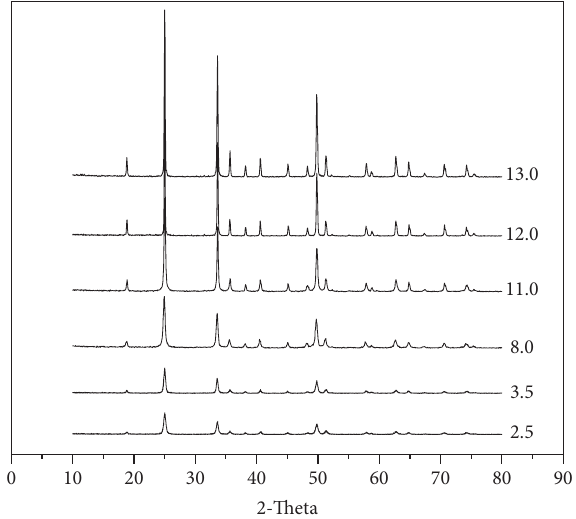
Figure 1: XRD patterns of the samples produced with different final pH values at 180 ° C for 24h through hydrothermal route.